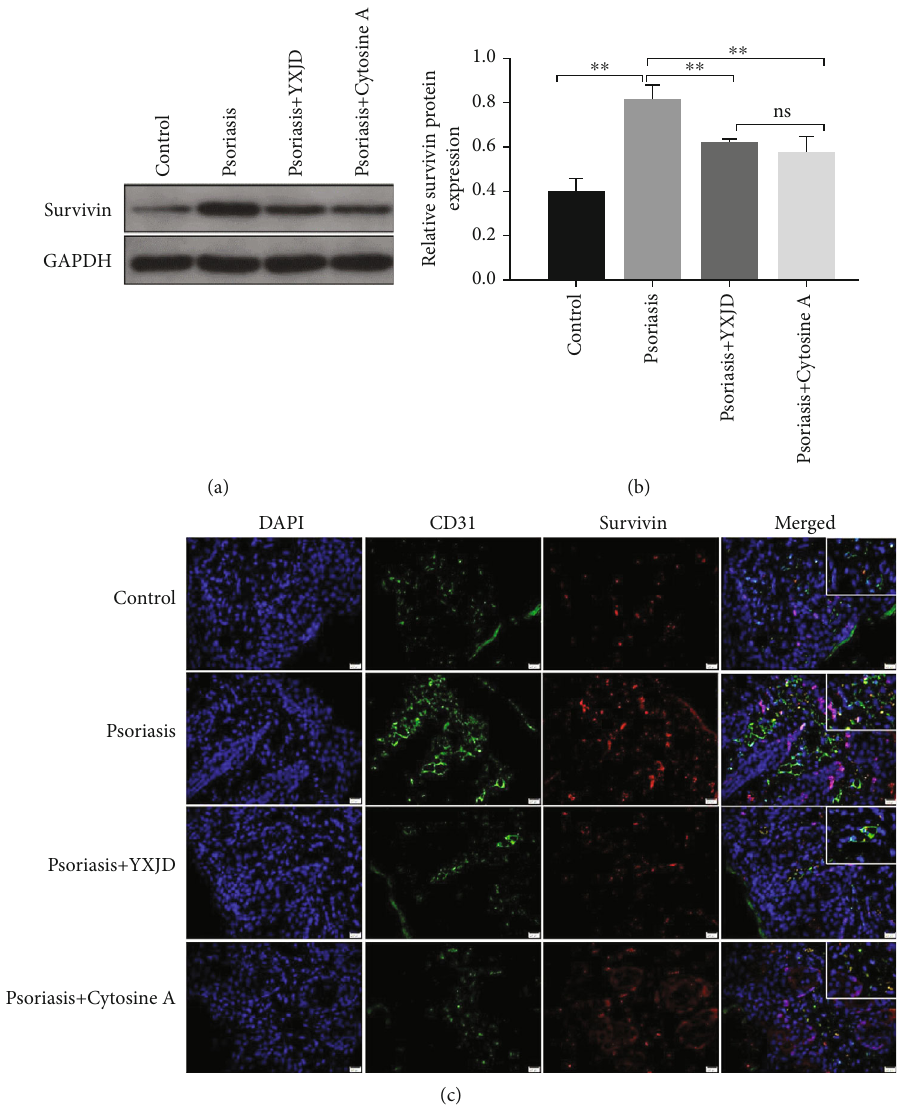
Figure 3: Protein levels and localization of Survivin, as detected by Western blot and immunochemical staining and immuno fl uorescence analysis. Survivin expression was evaluated by Western blotting (a). The expression of Survivin was increased in the model groups compared with the control groups, and YXJD inhibited the expression of Survivin in the lesions of IMQ-induced PA mice (b). Survivin protein expression in the mice was measured by immunochemical staining and immuno fl uorescence analysis (c). Double immuno fl uorescence staining for CD31 (green) and Survivin (red) in a representative skin sample from the 4 groups are shown. Nuclei were counterstained with DAPI